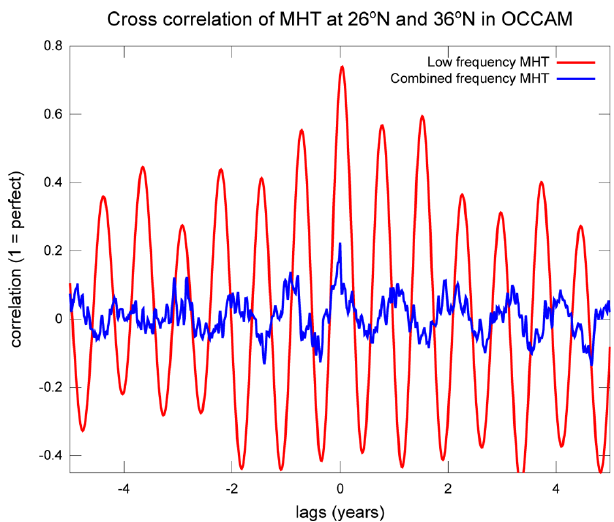
Fig. 3. Figure illustrating the change in cross-correlation investigat- ing the full (combined, blue) and the low-frequency (red) heat flux F 26 ◦ and F 36 ◦ N . To separate the high- and low-frequency trans- port, a low-pass filter was used. Here the cut-off frequency of 3.7 cycles/year was used, as a marked decrease in the variance of both F 26 ◦ N and F 36 ◦ N was observed using